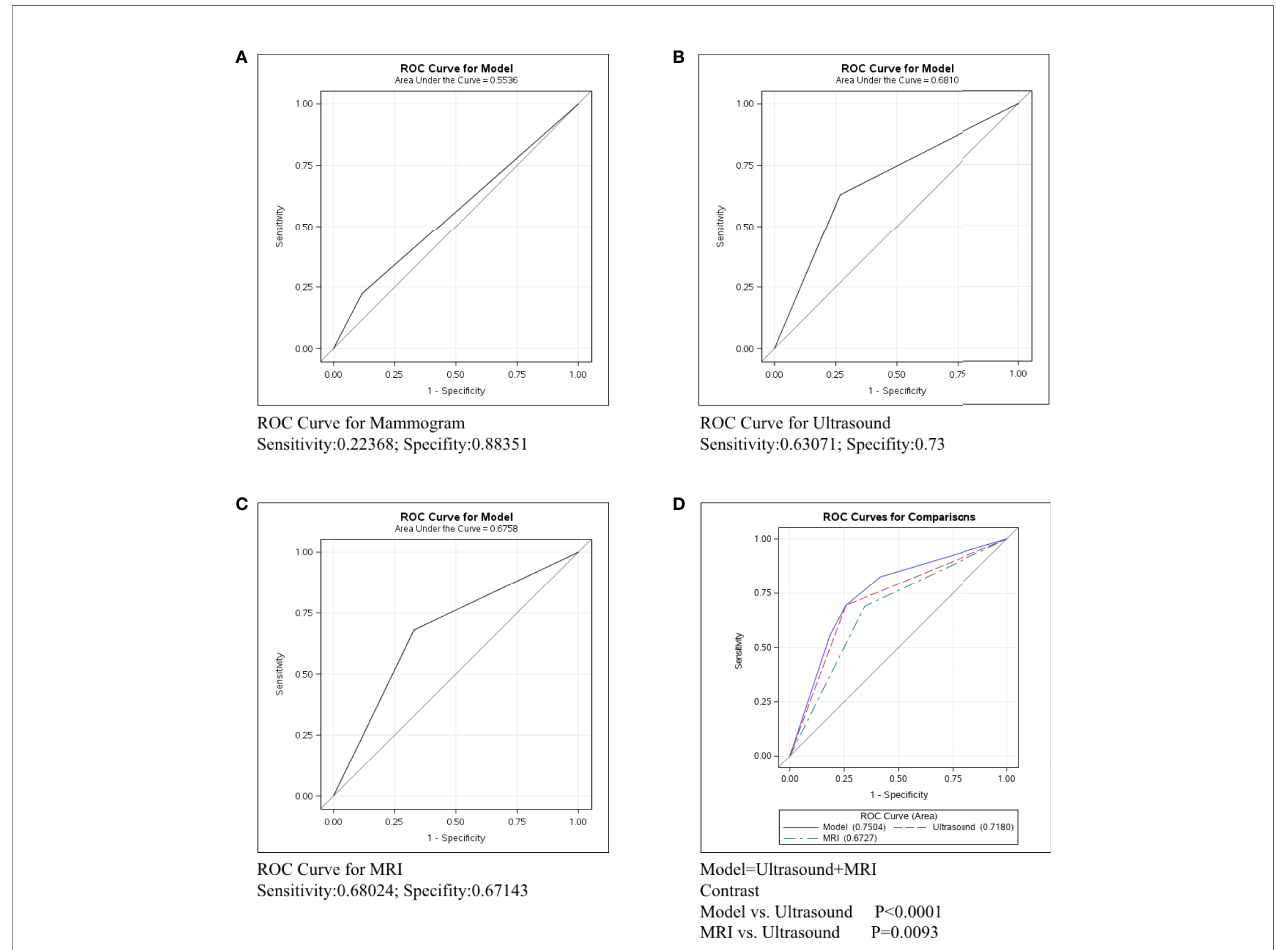
FIGURE 1 | ROC curve analysis for speci fi c imaging examination in all molecular subtypes. The vertical axis is sensitivity, the horizontal axis is 1-speci fi city. AUC is a parameter used to measure the value of imaging examination in the prediction of axillary lymph nodes. (A) ROC curve for mammogram. (B) ROC curve for ultrasound. (C) ROC curve for MRI. (D) ROC curve for